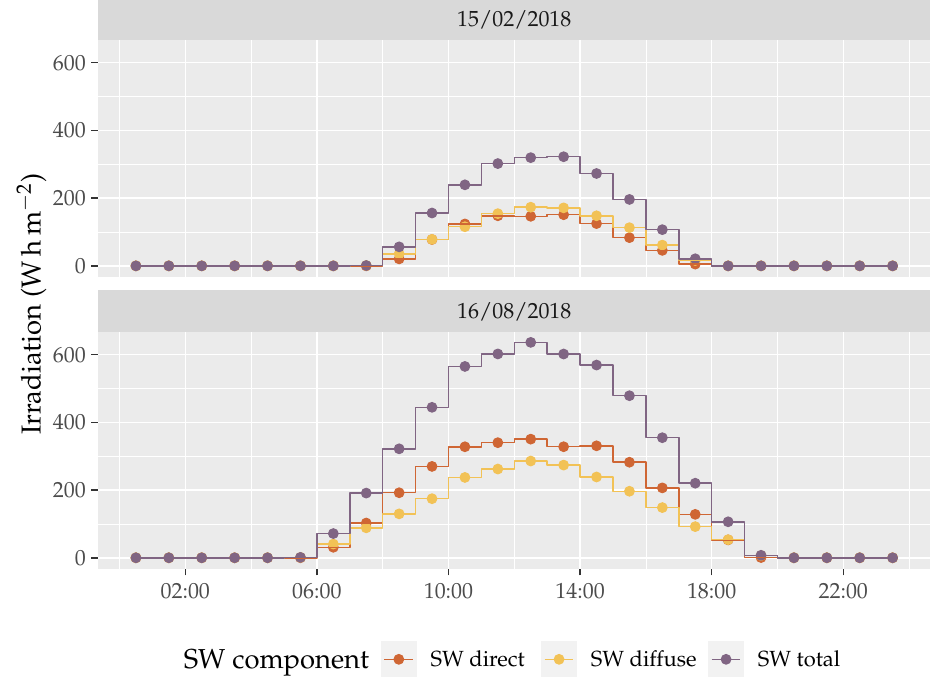
Figure 9. Shortwave radiation used as